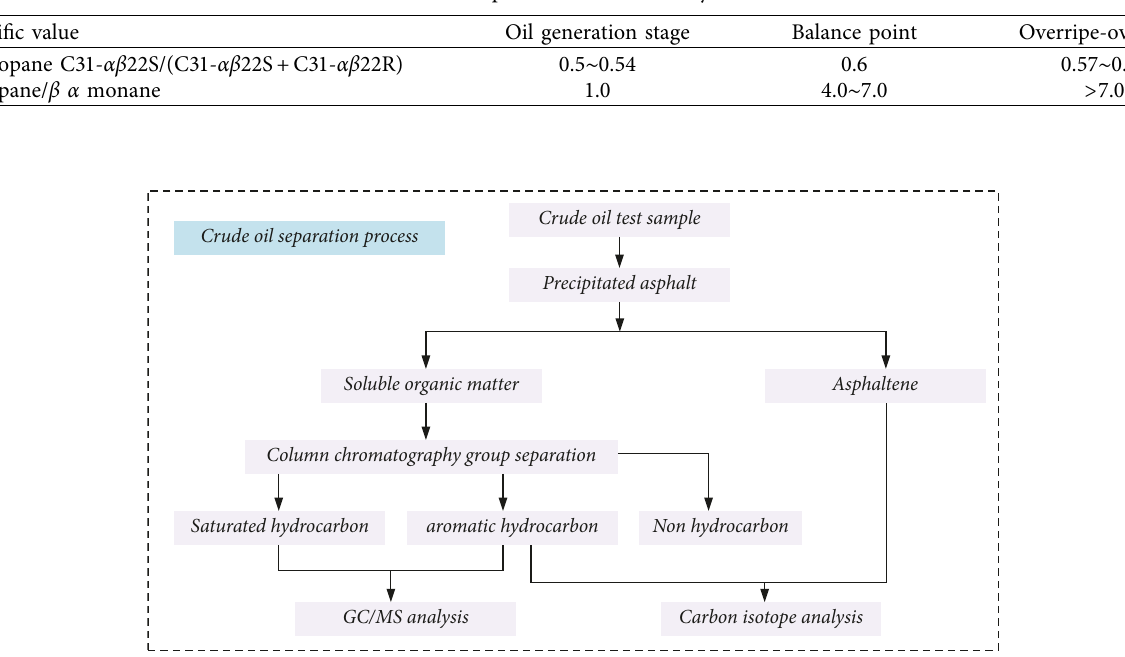
Figure 3: Crude oil separation